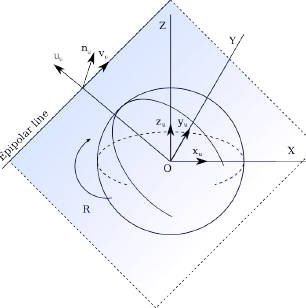
Figure 2: An epipolar circle is the projection of an epipolar line onto the unit sphere. An epipolar circle is inside the plane defined by the epipolar line and the sphere’s center.